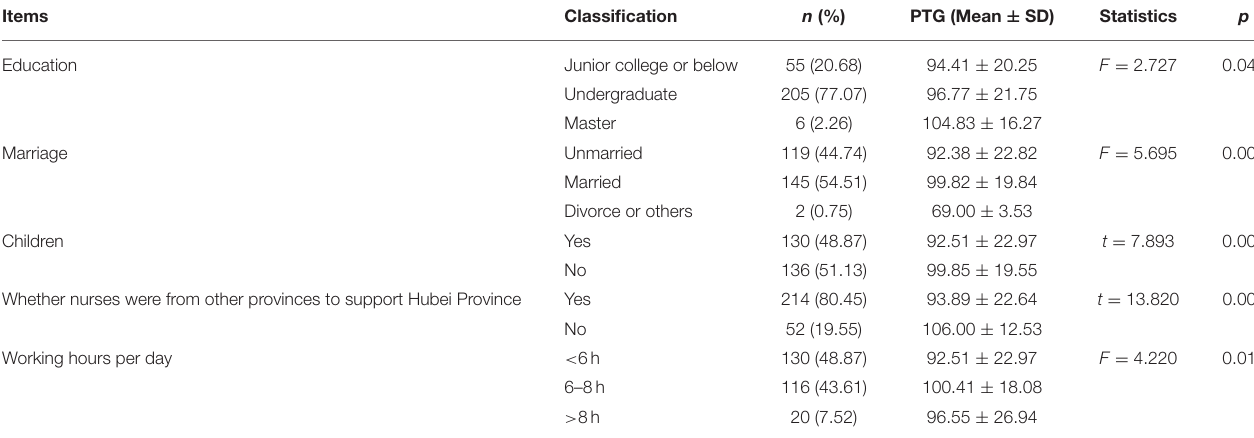
TABLE 3 | Univariate analysis of the PTG of nurses (x ± s, N = 266). Items